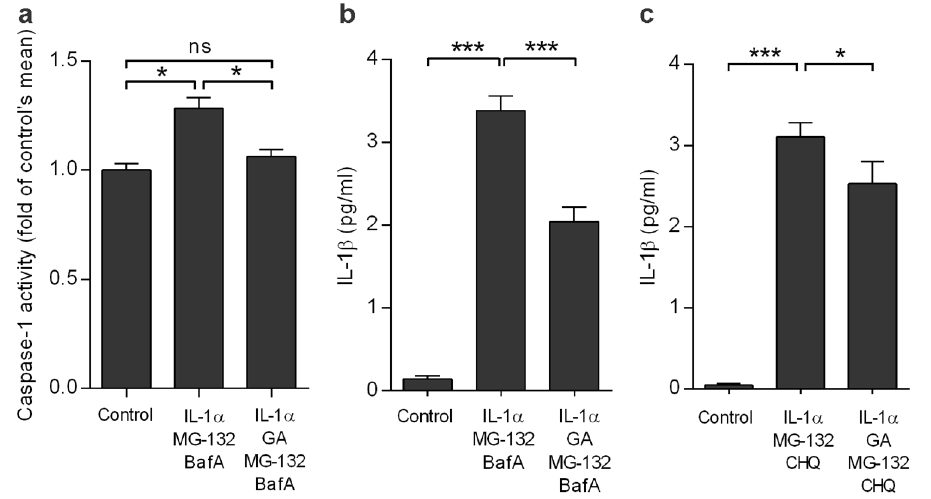
Figure 3. Geldanamycin (GA) inhibits the NLRP3 activation in ARPE-19 cells. Treatment with GA reduced the activity of caspase-1 ( a ) and the release of IL-1 β ( b , c ). Caspase-1 activity was measured from the cell lysates using a commercial kit. IL-1 β was measured with ELISA from the MG-132 and bafilomycin A1 (BafA) or MG-132 and chloroquine (CHQ)-treated cell culture medium samples. Results are presented as mean ± SEM. * P < 0.05, *** P < 0.001, ns = not significant, Mann–Whitney U